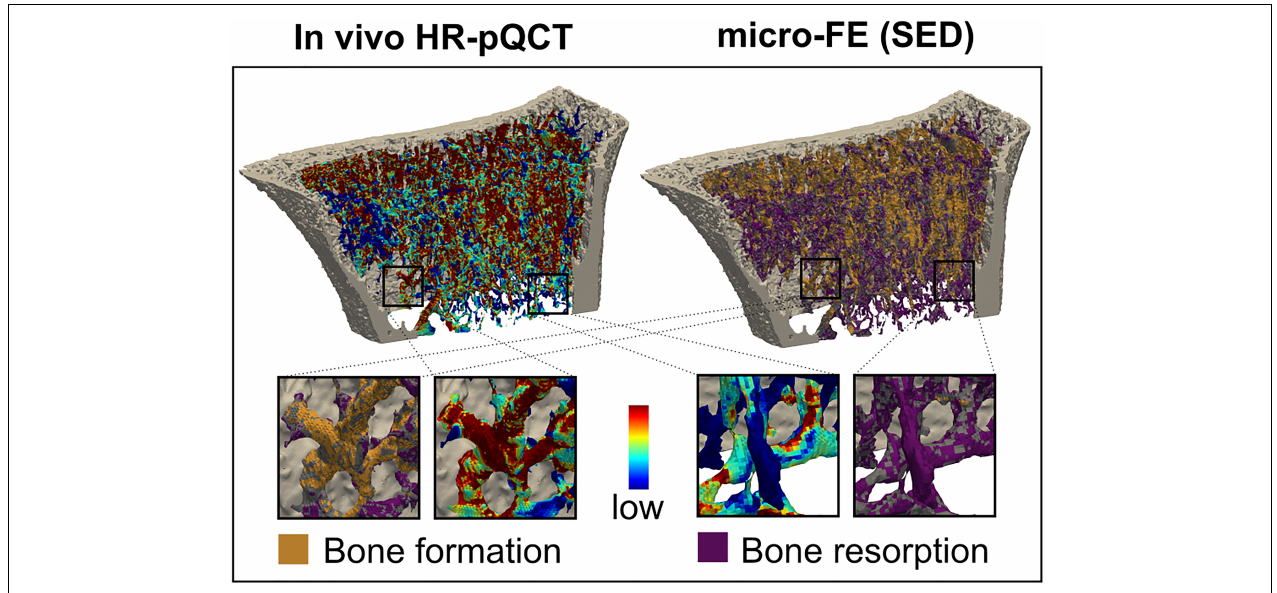
FIGURE 8 | Comparison of remodelling sites with the mechanical environment. Longitudinal in vivo high-resolution peripheral quantitative computed tomography (HR-pQCT) scans identified bone formation, quiescence, and resorption and were directly compared to the local mechanical environment. The inset shows an enlarged view of the correspondence between bone formation and high signal and low signal